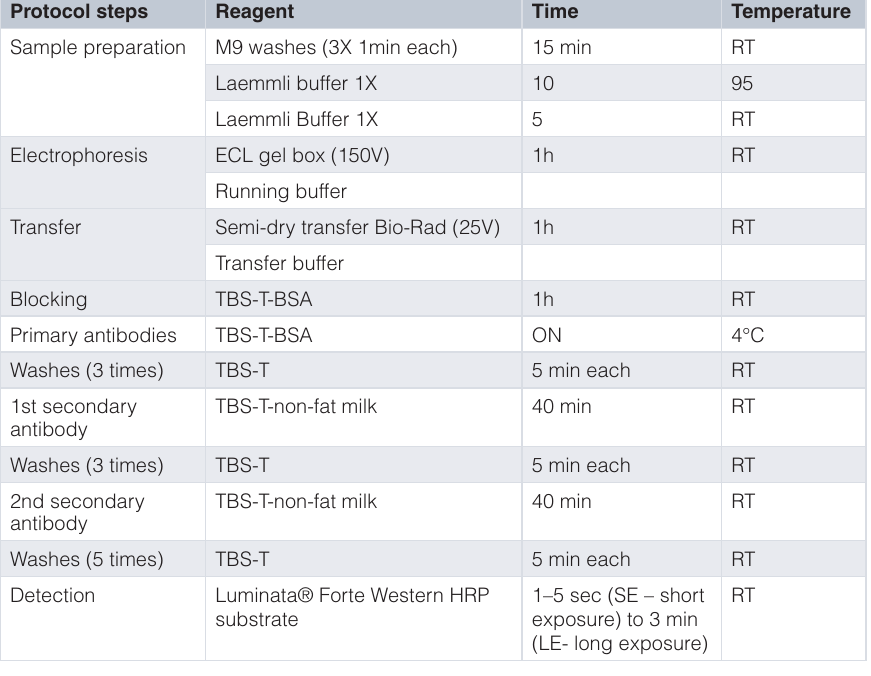
Table 3. Western blot protocol.